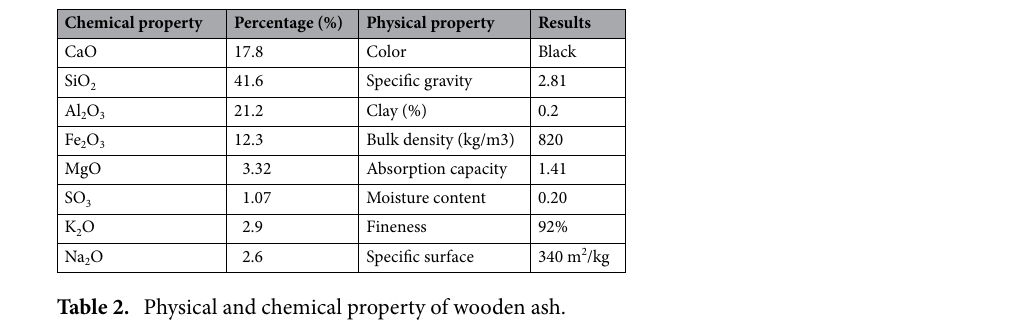
Table 2. Physical and chemical property of wooden ash.